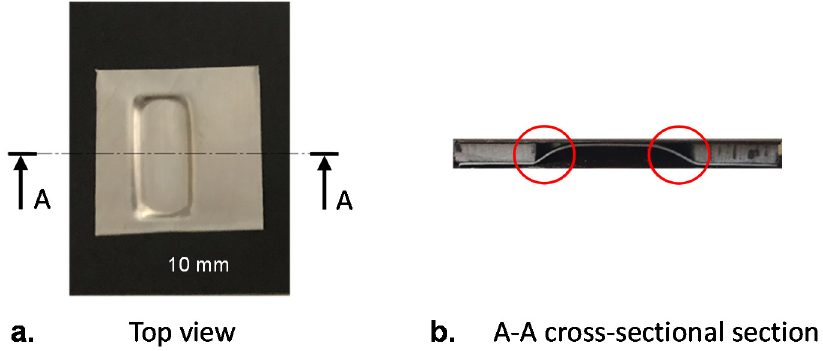
Figure 19. MPW specimen with metallic patch in top view ( a ) and cross-sectional view ( b ) that shows incomplete filling of the opening in composite.